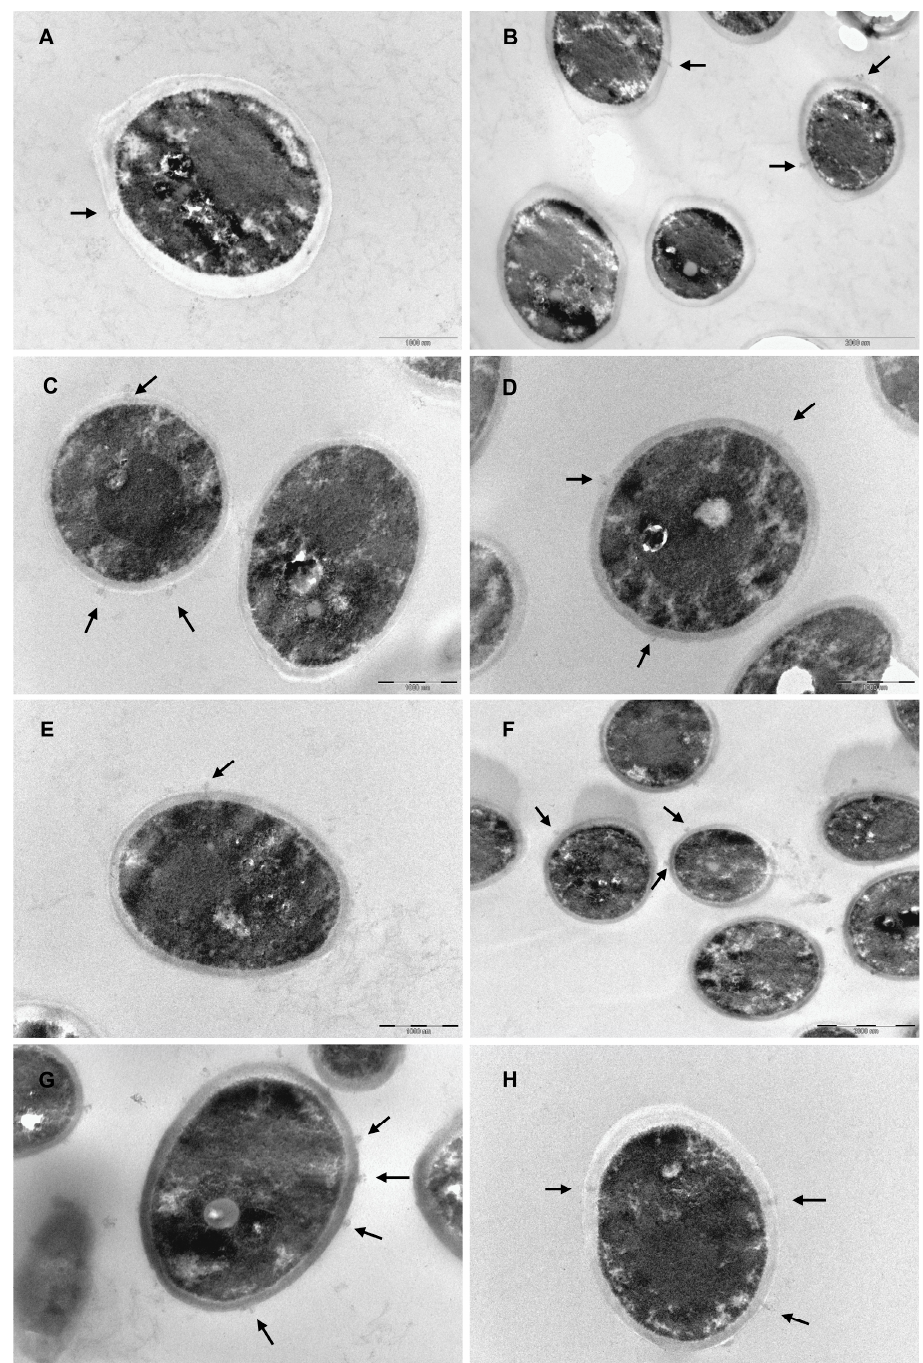
Figure 3. Transmission electron microscopic observations of C. parapsilosis . ( A , B ) non-treated fungal cells, ( A ) scale bar 1000 nm, ( B ) scale bar 2000 nm; ( C – E ) treated with caffeinated SCG extract (275 µg/mL), scale bar: 1000 nm; ( F – H ) treated with decaffeinated SCG extract (150 µg/mL), ( F ) scale bar: 1000 nm, and ( G , H ) scale bar: 2000 nm. Black arrows indicate structures crossing the membrane and cell wall.